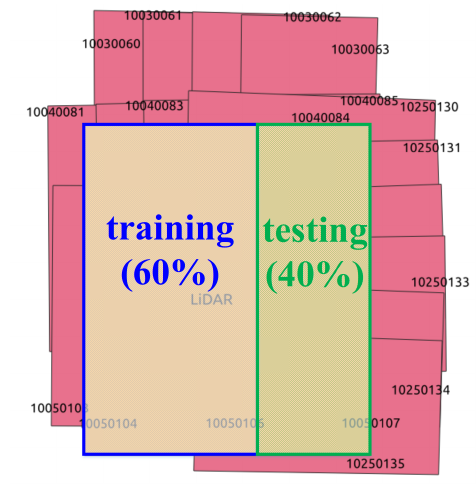
Figure 3. Training and testing area on Vahingen.